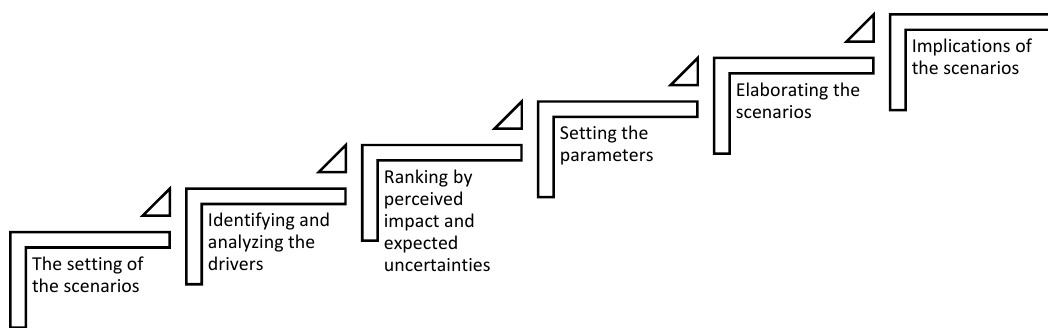
Figure 1. The scenario building process (adapted from the European Foresight Platform (EFP), n.d. [42]).